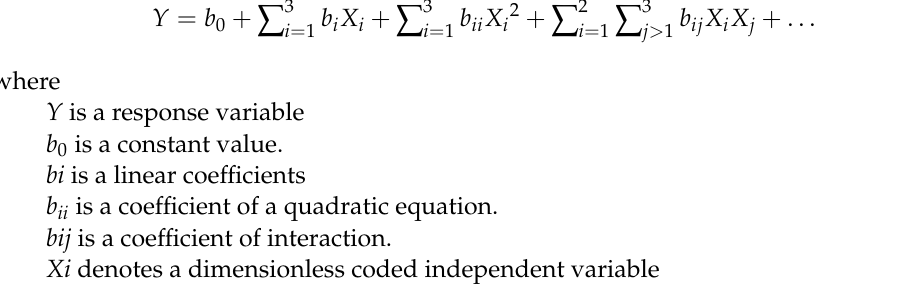
Table 1. The generalised second-order polynomial model is utilised in the response surface approach, as shown in Equation (1). As stated in Table 2, there are 15 experimental points, 12 of which are factorial design points and 3 of which are replicas of centre points. Minitab statistical software version 19 was used to apply the Box–Behnken design (BBD) to the experimental data.